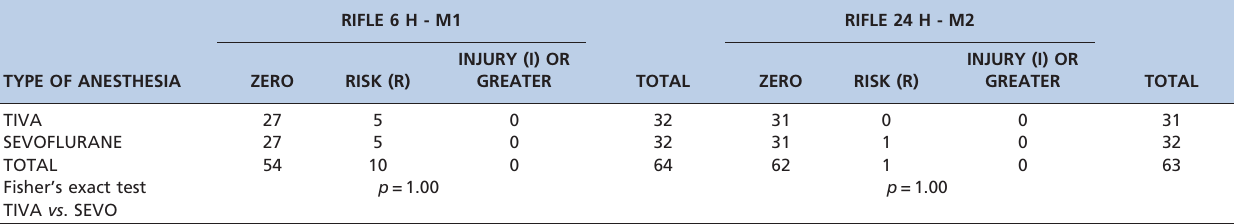
Table 3 - RIFLE criteria classifications by the type of anesthesia in M1 and